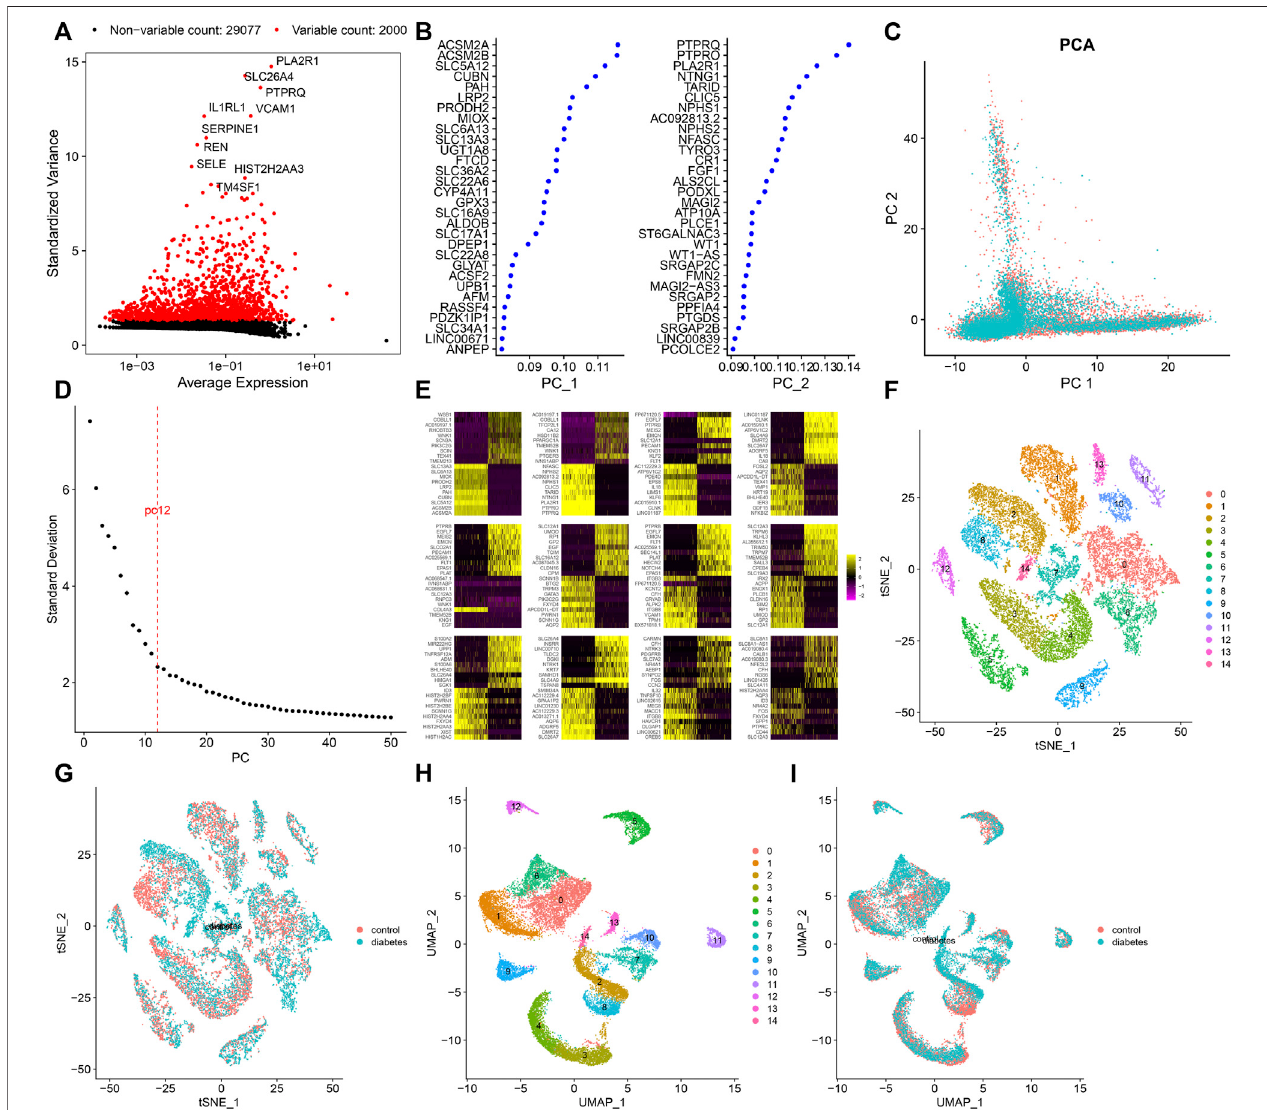
FIGURE3| Screeninghighlyvariablegenesandcellclustering. (A) Screeningthetop2,000highlyvariablegenesacrosscellsbasedonscRNA-seqdata.Reddots indicate the highly variable genes and black dots indicate no signi fi cant genes. (B) Contribution of genes in the fi rst two PCs. (C) PCA of fi ltered cells from the diabetic kidneyspecimens(greendots)andcontrols(reddots). (D) ElbowplotforidentifyingtheoptimalPCs. (E) HeatmapvisualizingtheexpressionofmarkergenesineachPC. Cell clustering based on the (F,G) t-SNE and (H,I) UMAP methods.